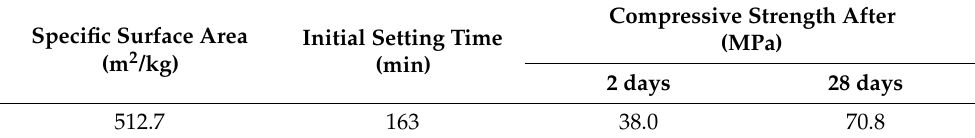
Table 2. Cement physical and strength properties [59].